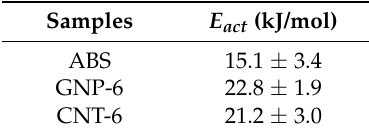
Table 5. The activation energy for the creep